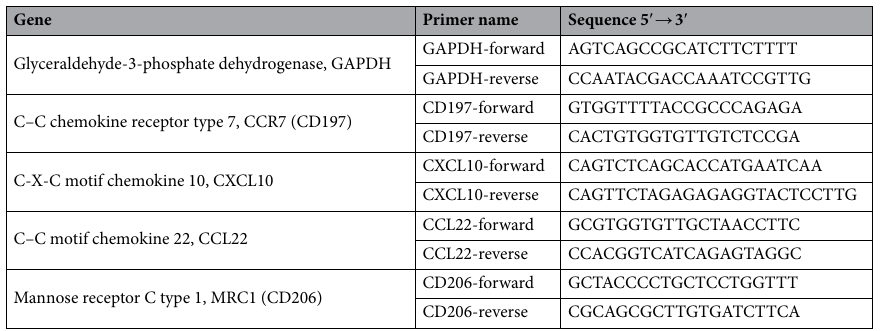
Table 1. Sequence of the primers used for quantification of macrophage gene